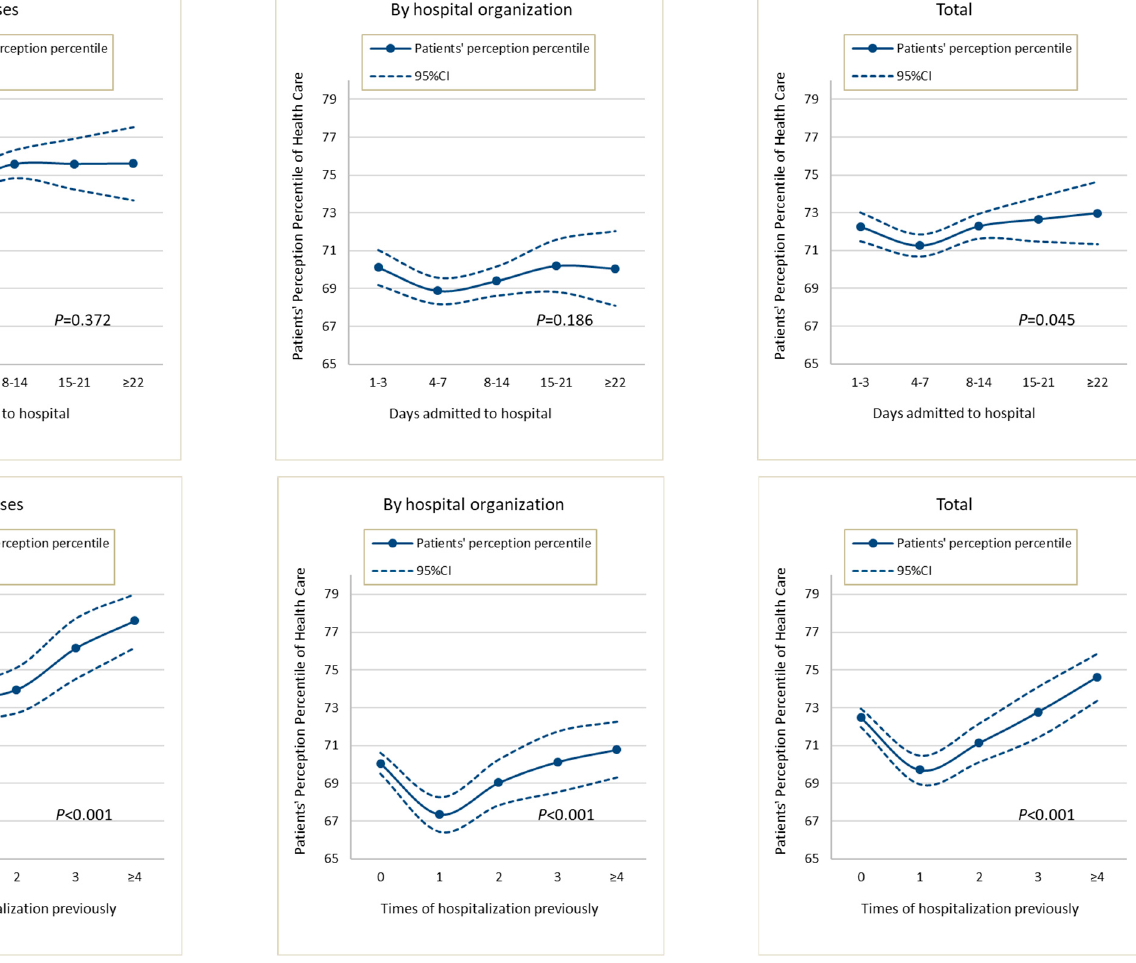
Figure 2. Dose – response curves of patients’ perceptions with days admitted to hospital and times of hospitalization previously.